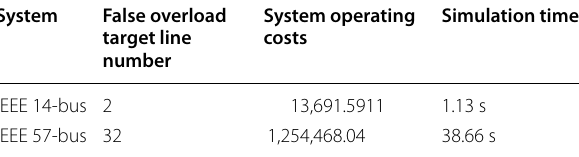
Table 2 Comparison of results of false overload target line selection methods for the two different systems